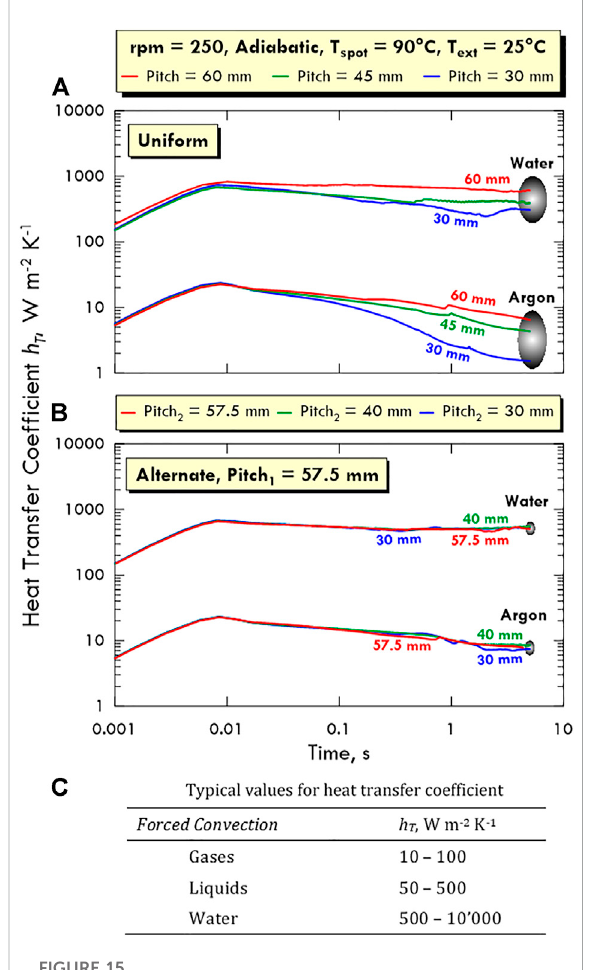
FIGURE 15 Time pro fi le of the heat transfer coef fi cient h T for different pitch values for both fl uids in (A) uniform and (B) alternate con fi guration. (C) Typical values of h T in different cases. Values reported from the Table 14.1-1 of Bird et al. (2002). T spot = 90 ° C, T ext = 25 °